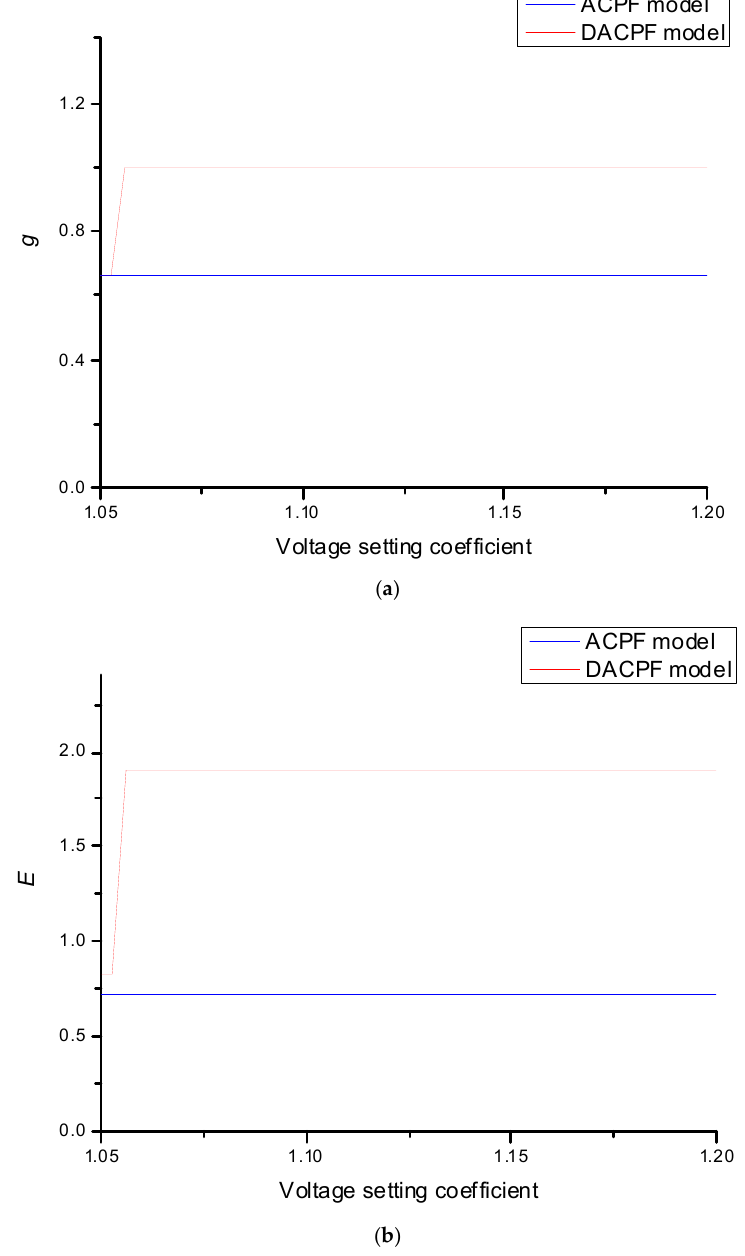
Figure 8. Comparative analysis of the impact of grid voltage tolerance capability, ( a ) Connectivity; ( b ) Global effective performance.